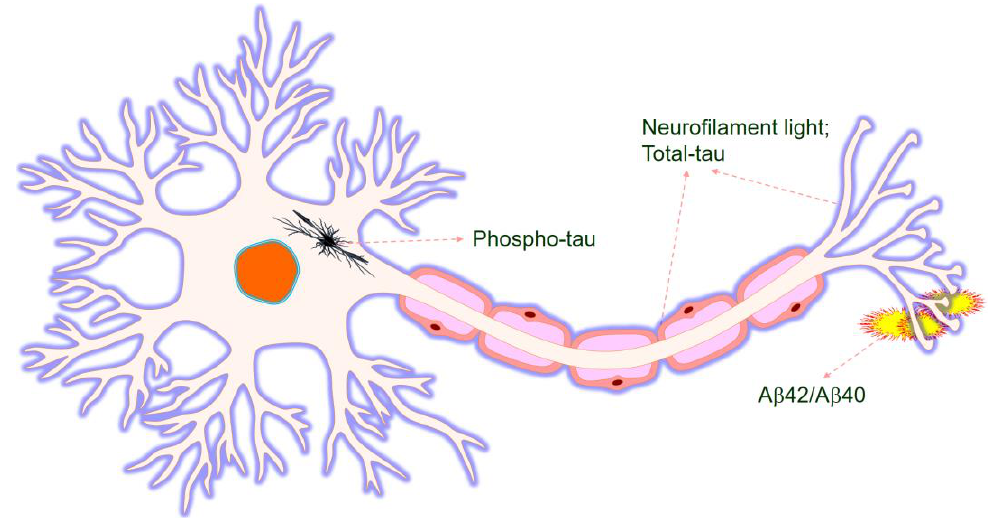
Figure 2. Neurofilament, tau and A β aggregation as indicators in the AD brain.